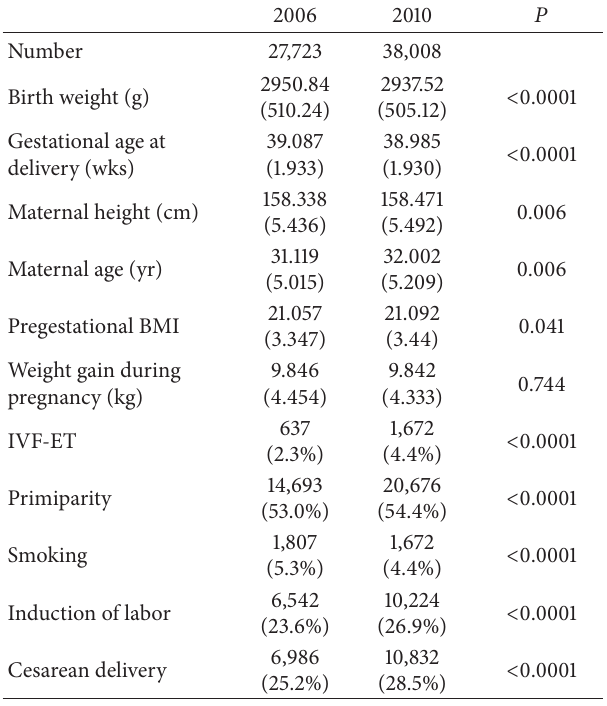
Table 1: Comparison of the perinatal/obstetrical variables between 2006 and 2010: results of the univariate analysis (total).